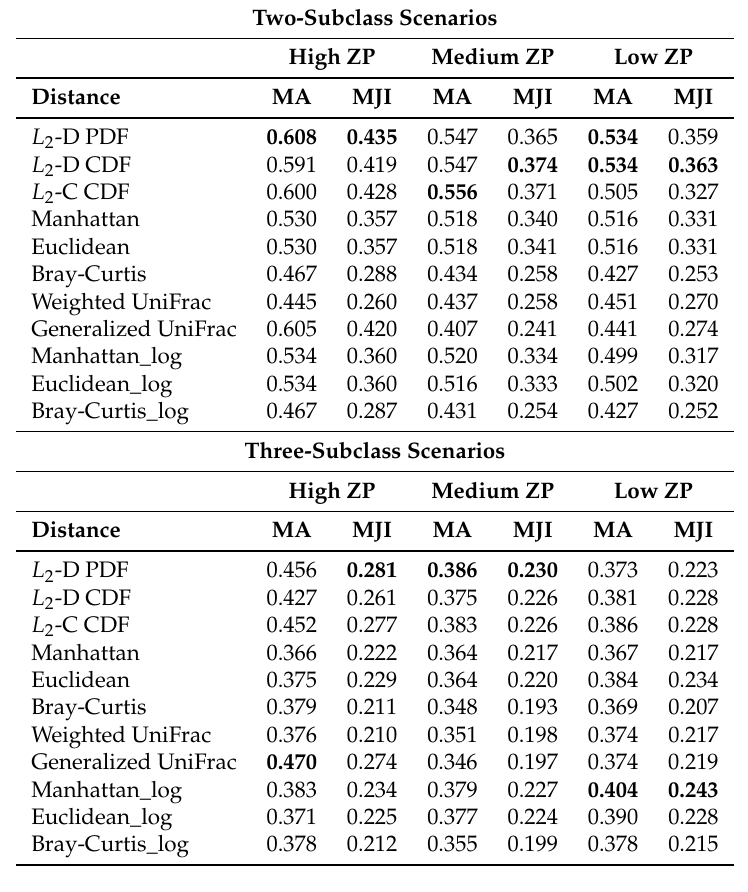
Table 1. Mean accuracy (MA) and mean Jaccard index (MJI) estimations. A bold value represents the best cases under each scenario. Distances calculation was conducted on the simulated data inputs with and without log-transformation: Manhattan_log, Euclidean_log, Bray-Curtis_log were models using log-transformation, while L 2 -D PDF, L 2 -D CDF, L 2 -C CDF, Manhattan, Euclidean, Bray-Curtis, weighted UniFrac, and generalized UniFrac were without log-transformation.